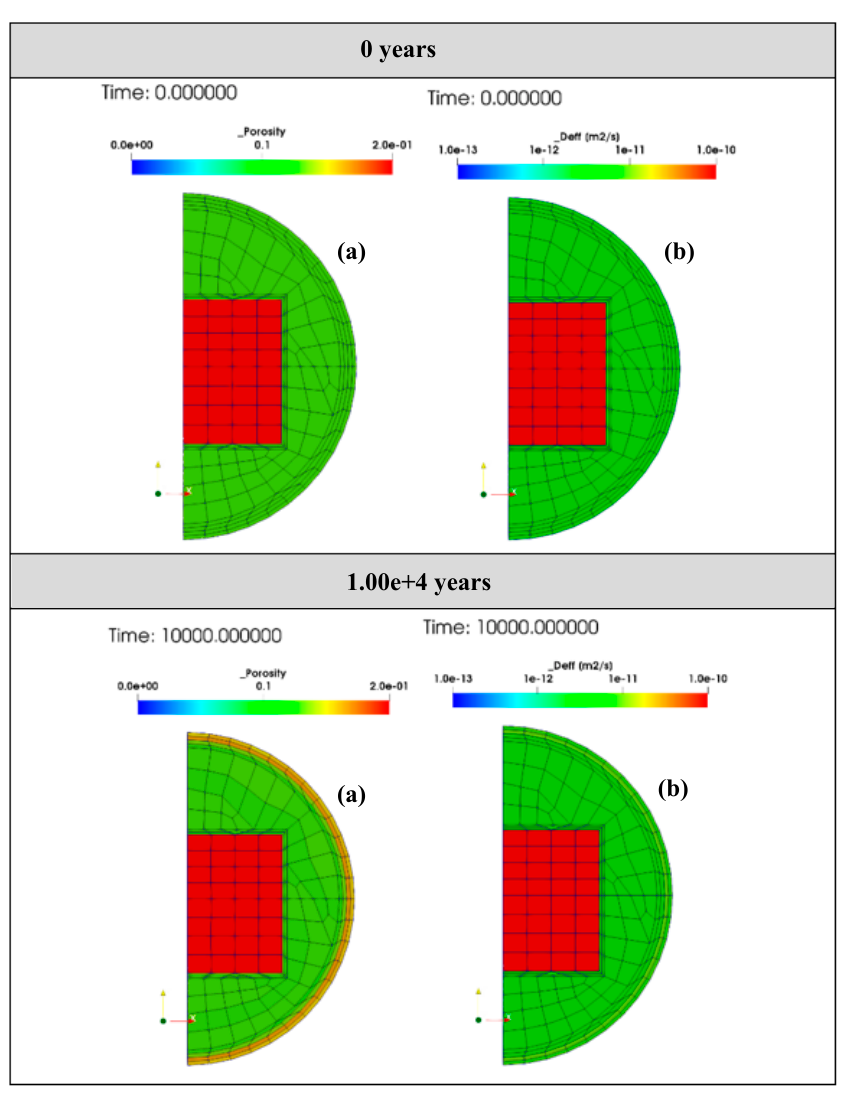
Figure 11. Profiles at 0 years (top) and 10,000 years (bottom) of porosity ( a ) due to chemical alteration calculated by GARFIELD-CHEM, and effective diffusion coefficients ( b ).